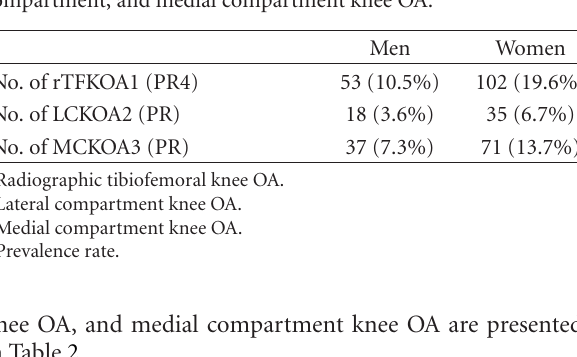
Table 2: Prevalence rates of radiographic tibiofemoral, lateral compartment, and medial compartment knee